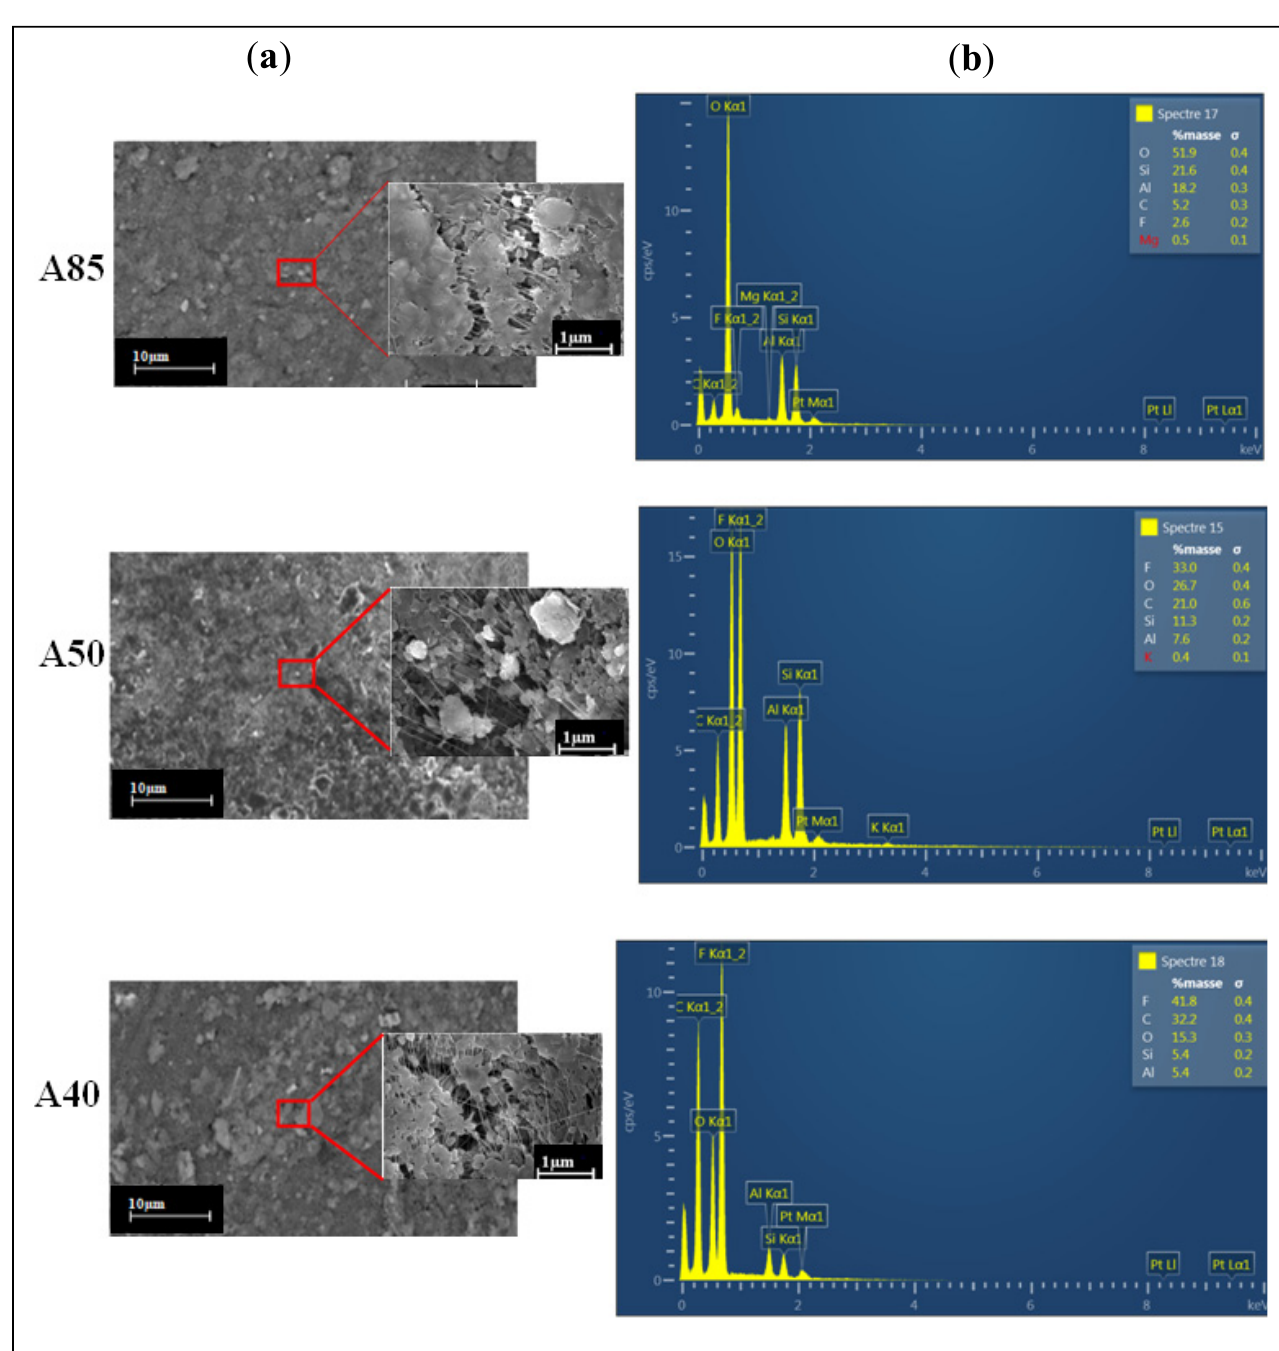
Figure 5. SEM surface images ( a ) and EDX spectra ( b ) of the three studied